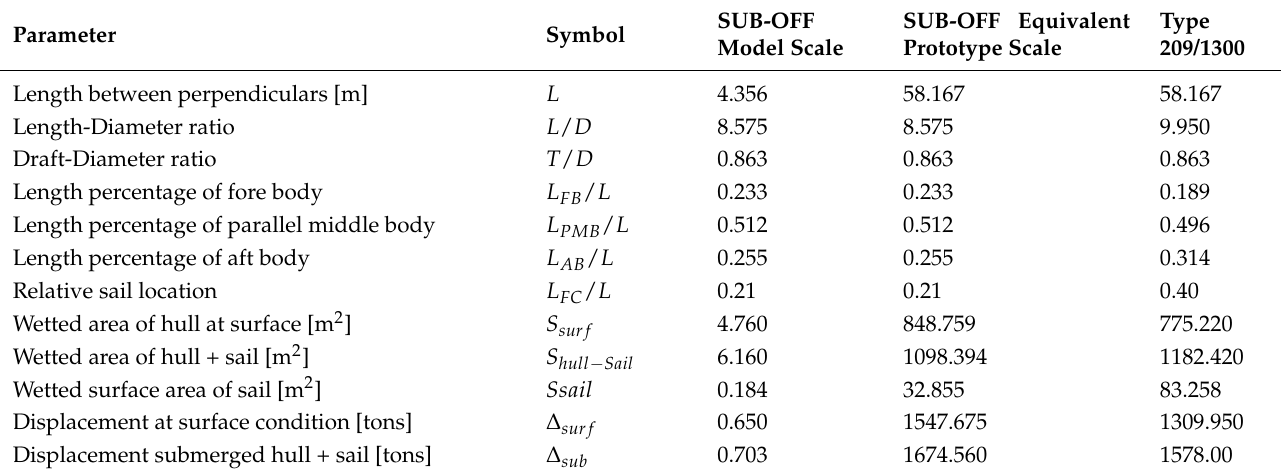
Table 1. Main characteristics comparison between DARPA–SUBOFF and Type 209/1300 submarines.